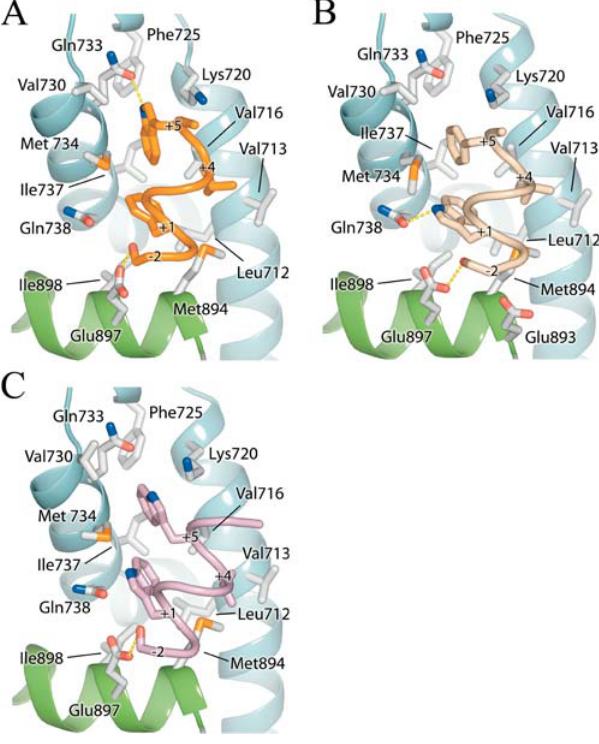
carbons are labeled. DOI: 10.1371/journal.pbio.0020274.g006